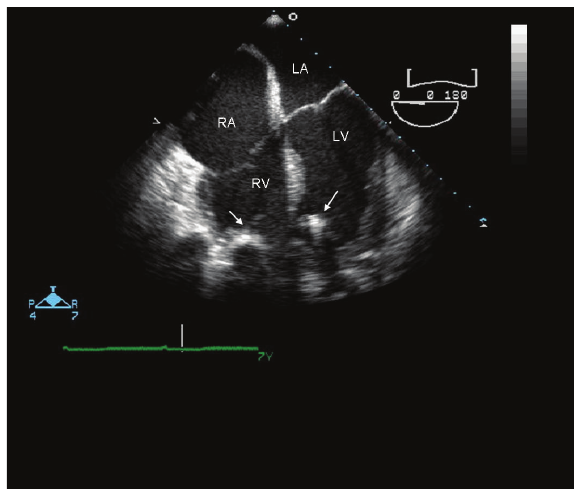
Figure 1: Transoesophageal echocardiogram 4 chamber view: biventricular assist device inlet cannulas in the left and right ventricles are shown (arrow). RA: right atrium, LA: left atrium, RV: right ventricle and LV: left